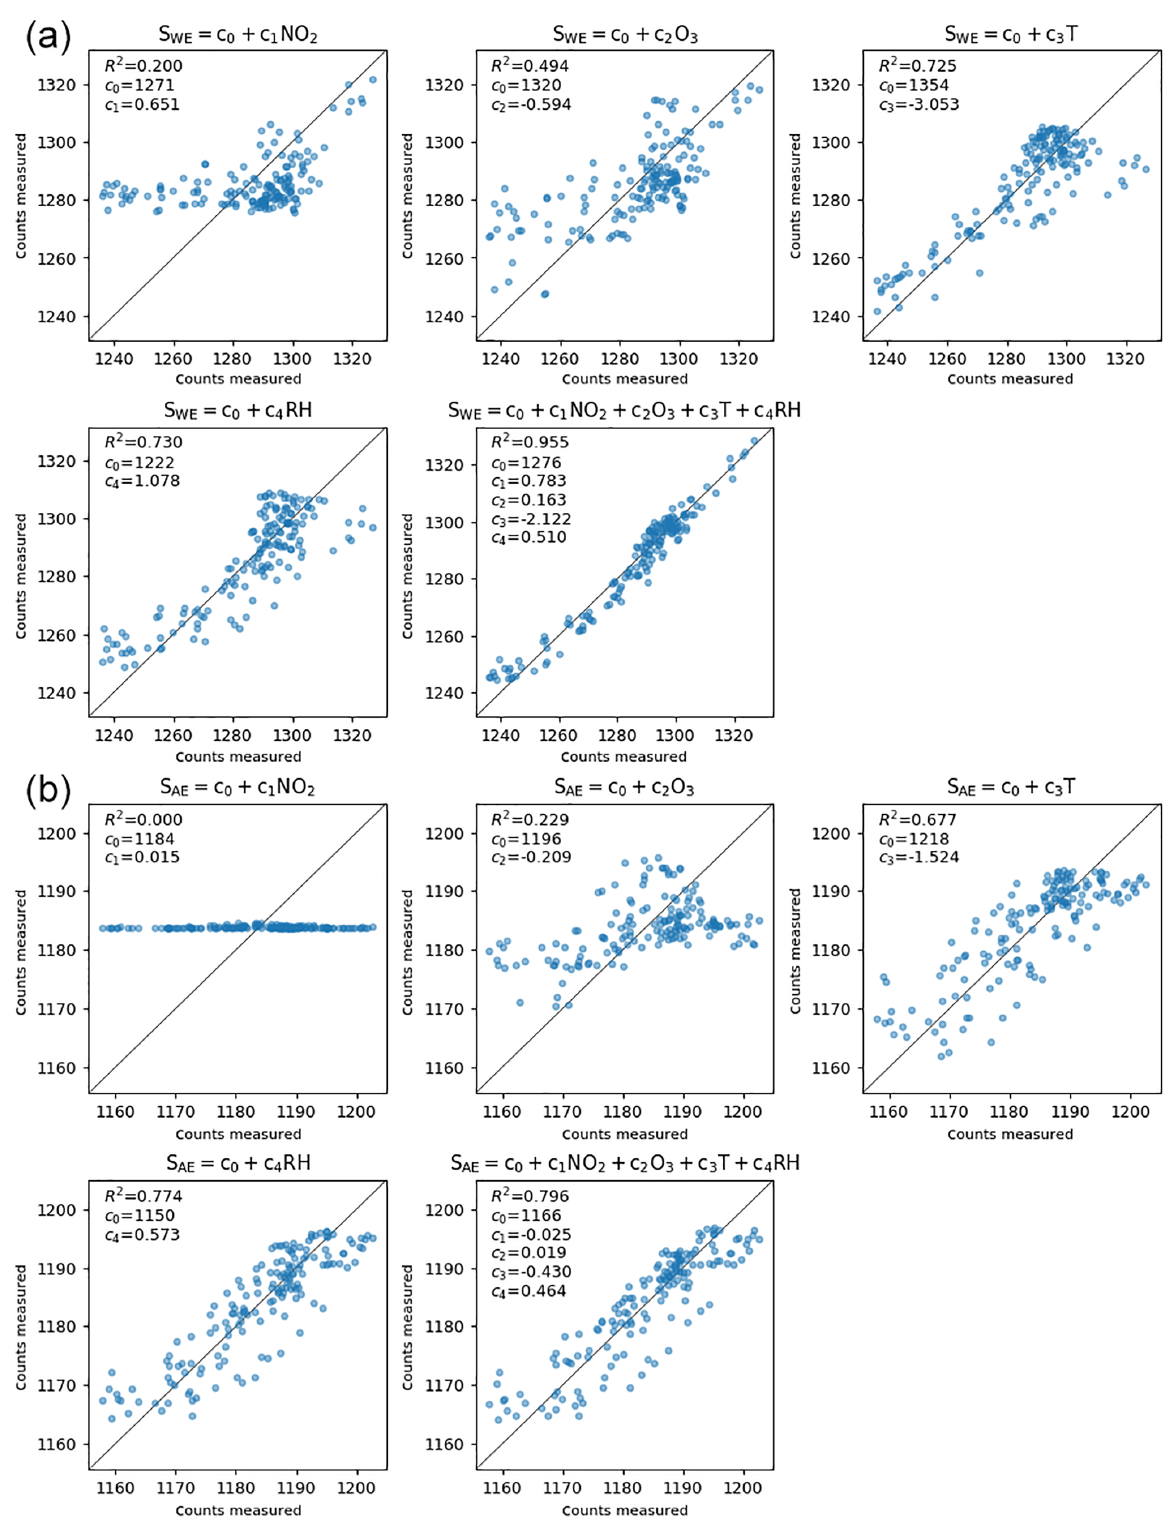
Figure 5. Typical sensor performance (SD10) explained as a linear regression of respectively NO 2 , O 3 , T , RH, and all variables. (a) The results for the working electrode and (b) for the auxiliary electrode. The axes represent the A / D converter counts, which are proportional to the currents generated by the sensor at the corresponding